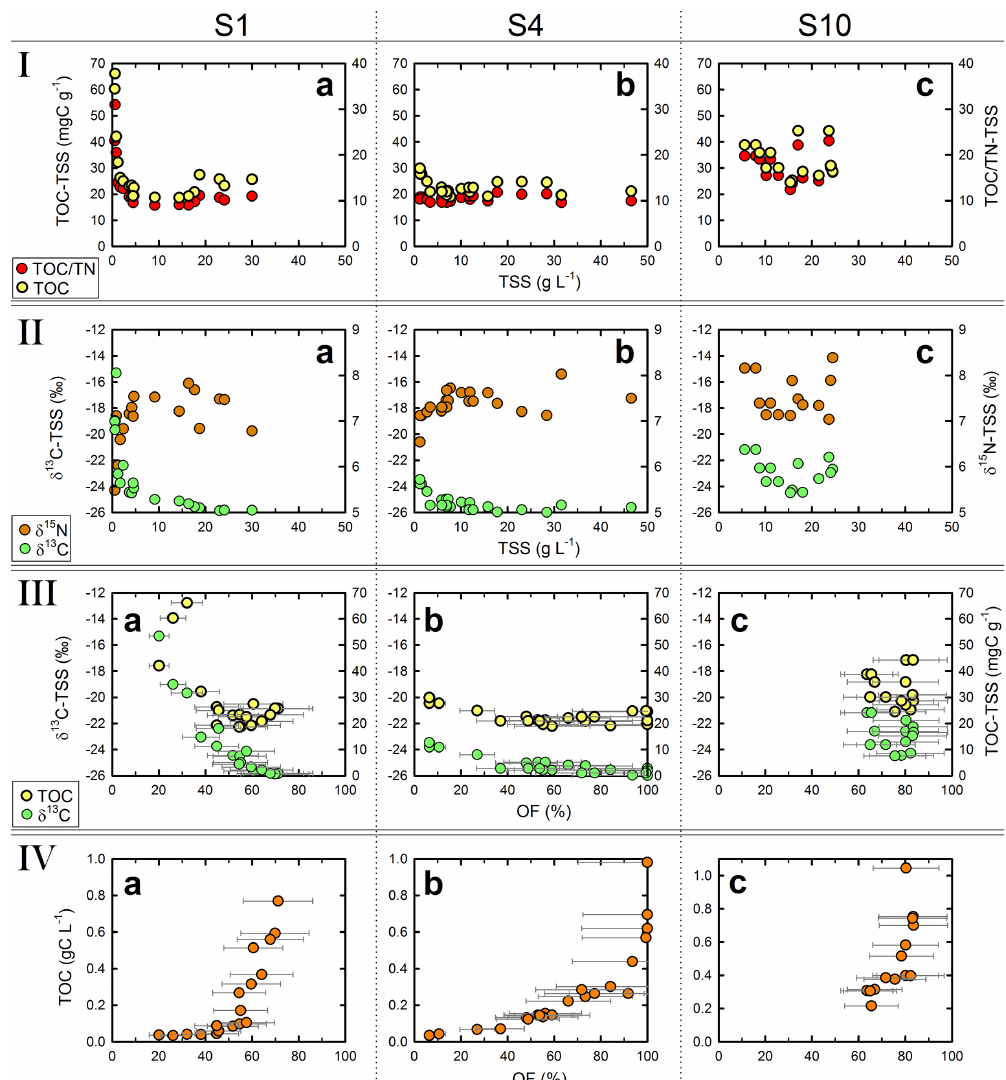
Figure 5. Relationships between total suspended sediment load (TSS), total organic carbon concentration in the TSS (TOC-TSS), total organic carbon:total nitrogen ratio in the TSS (TOC / TN-TSS), δ 13 C-TSS, δ 15 N-TSS, total organic carbon load (TOC) and overland flow contribution estimates (OF): (a) at upstream station S1 (Houay Pano stream), (b) at intermediate station S4, and (c) at downstream station S10, during the 23 May 2012 flood. In (III) and (IV), circles represent the median values of the variability range (horizontal bars) of estimated OF